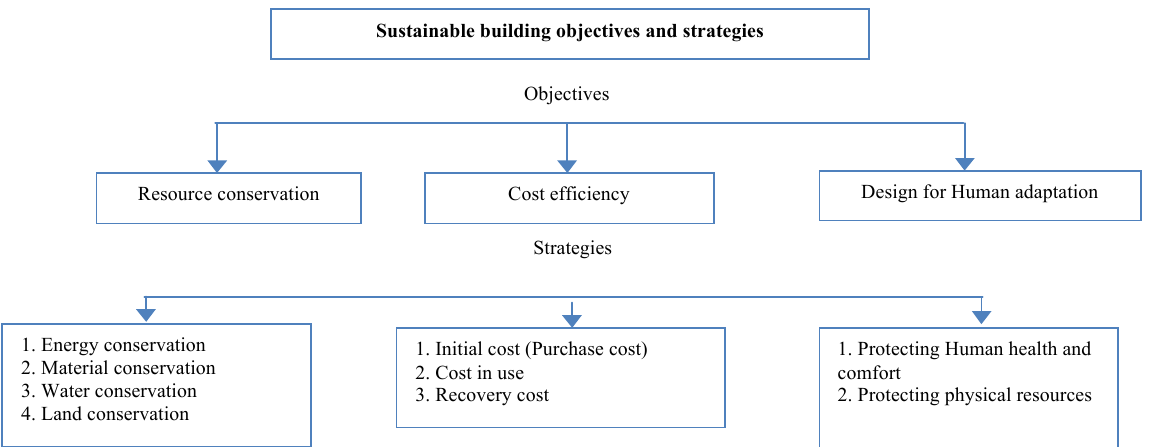
Figure 1. Framework for implementing sustainability in building